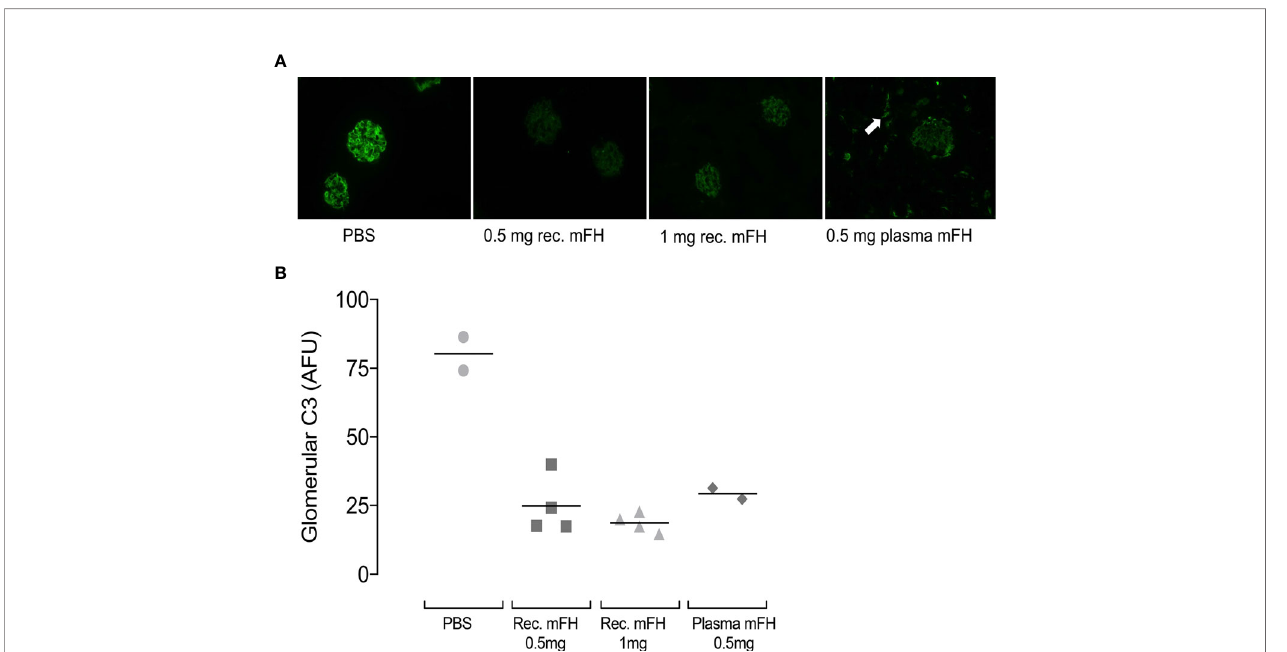
FIGURE 5 | Glomerular C3 immunostaining in CFH -/- mice after mFH injection. (A) Representative images of C3 staining 24 hours after injection of FH (or vehicle) as indicated below each image. White arrow indicates tubulo-interstitial C3 staining in animals receiving mouse serum-derived FH. (B) Quantitation of fl uorescence intensities expressed in arbitrary fl uorescent units with horizontal bars denoting mean values. Rec. mFH, recombinant